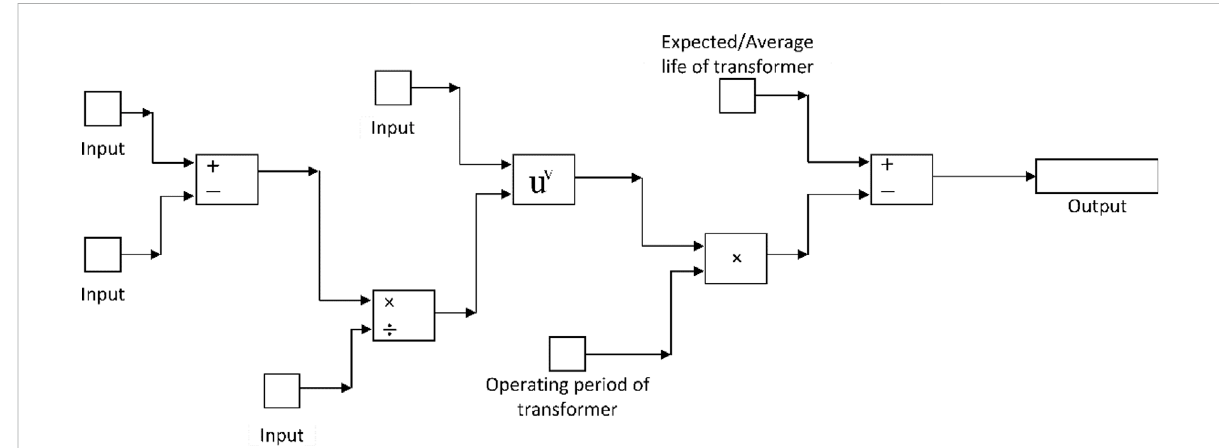
FIGURE 10 Fuzzy sublogic model of the remnant life of the transformer based on the relative aging rate.